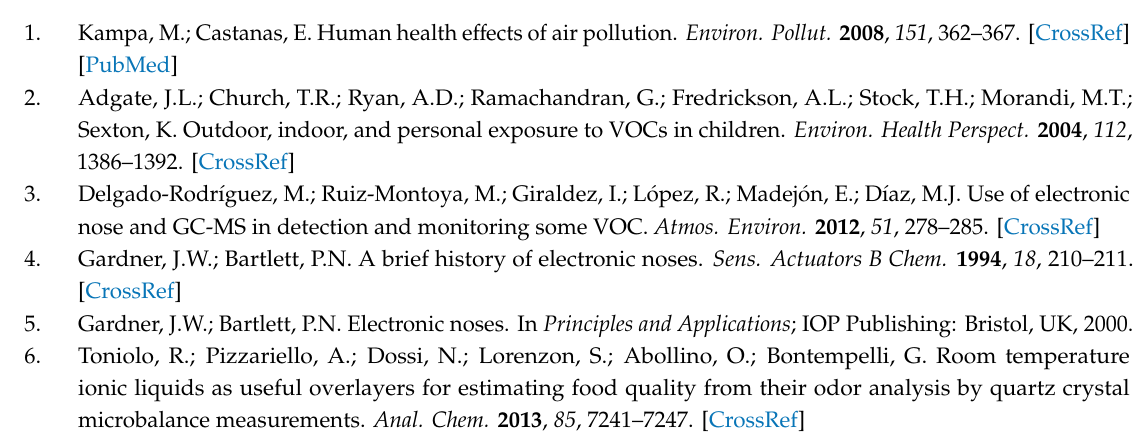
Figure S1. Schematic of QCM-based VSA, Figure S2. Structures of starting materials used to synthesize ILs, Figure S3. Schematic of QCM flow system, Figure S4. Electrospray ionization mass spectrometry (ESI-MS) spectra for [P 66614 ][DBS], Figure S5. Electrospray ionization mass spectrometry (ESI-MS) spectra for [P 66614 ][BS], Figure S6. Electrospray ionization mass spectrometry (ESI-MS) spectra for [P 66614 ][OBS], Figure S7. Fourier transform infrared (FT-IR) spectra for [P 66614 ][DBS], Figure S8. Fourier transform infrared (FT-IR) spectra for [P 66614 ][BS], Figure S9. Fourier transform infrared (FT-IR) spectra for [P 66614 ][OBS], Figure S10. Sensorgram for first replicate measurement, Figure S11. Canonical plot for discrimination of five chlorinated VOCs with respect to a five sensor VSA, Figure S12. Canonical plot for discrimination of five chlorinated VOCs with respect to a four sensor VSA, Figure S13. Canonical plot for discrimination of five chlorinated VOCs with respect to a six sensor